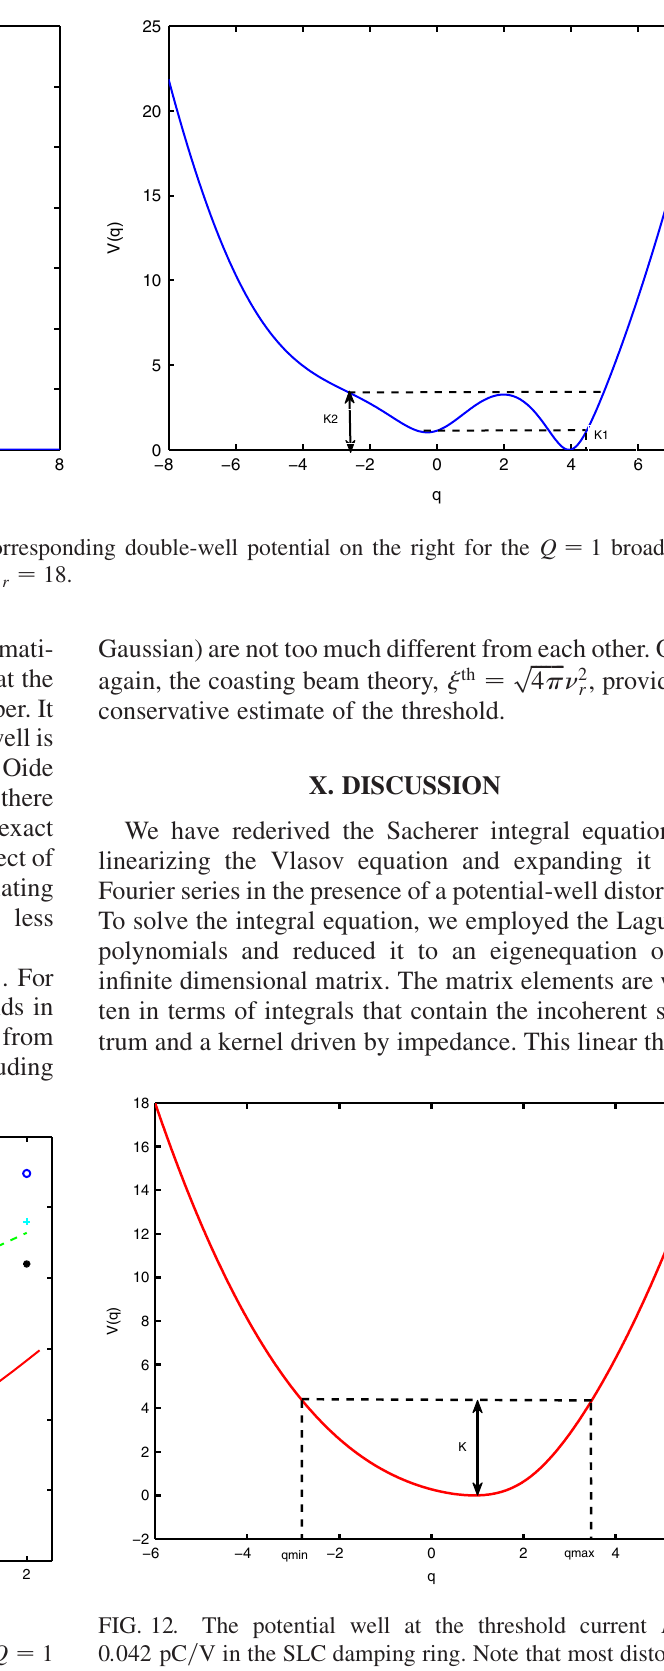
FIG. 11. Threshold as a function of (cid:7) broadband impedance model with various methods.